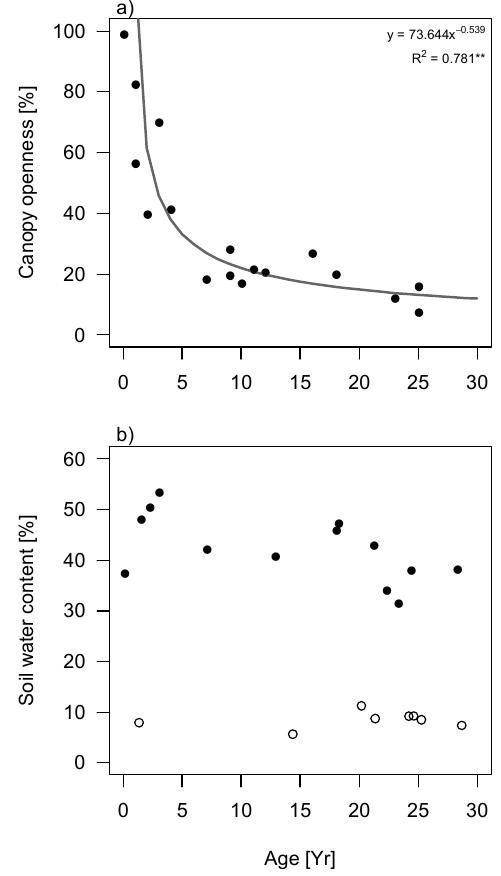
Figure S2. Changes in canopy openness and soil water content over successional plot